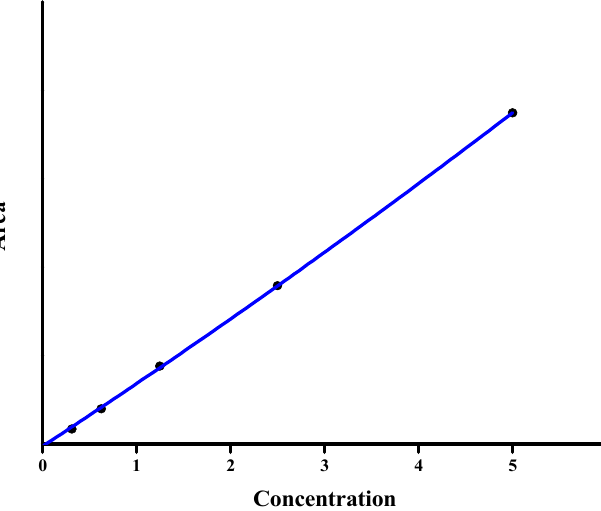
Figure 3. Plot of the peak area vs. the concentration and calibration curve for isoniazid quantification (concentration in μ g/mL).